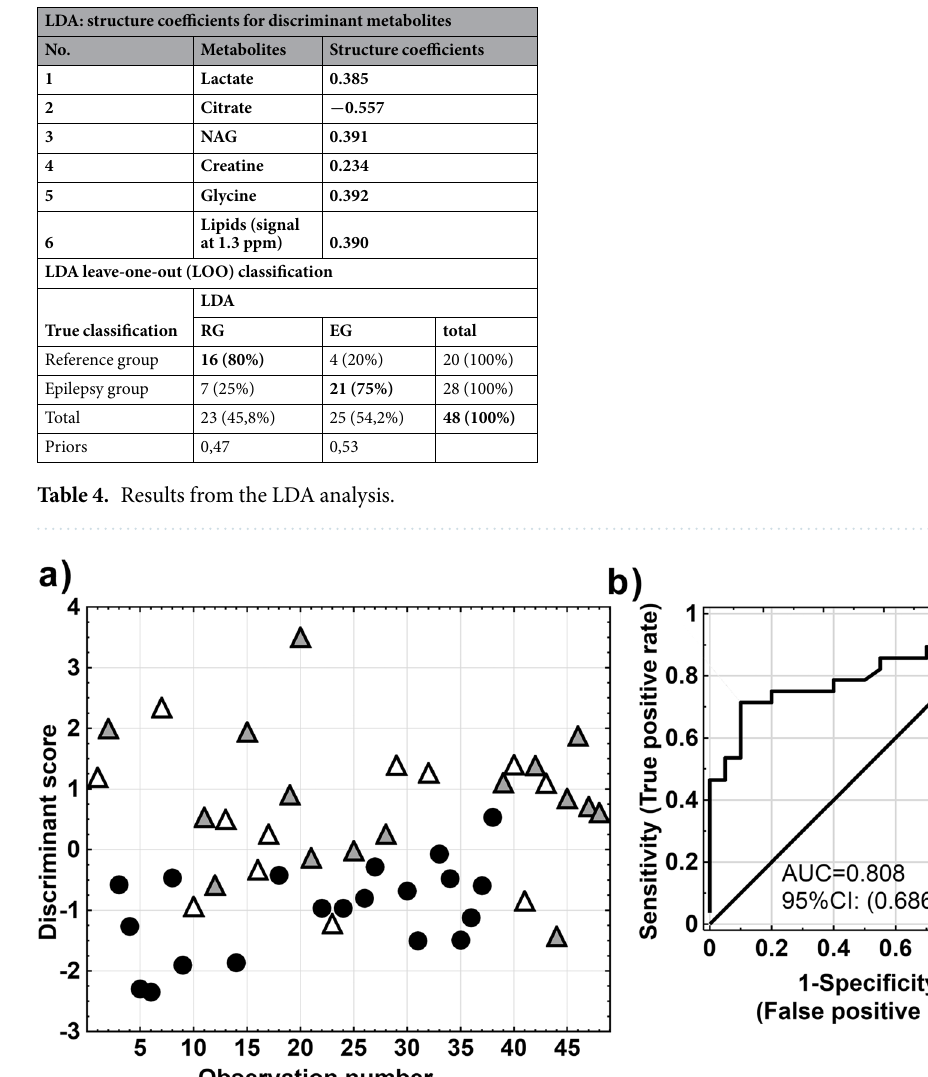
Figure 5. ( a ) Scatter plot of the LOO scores belonging to non-epileptic (RG, • ) and epileptic (EG 1 , Δ , EG 2 , ▼ ) children. ( b ) ROC plot for the leave-one-out (LOO) classification model; AUC equals 0.808 and 95%CI is (0.686, 0.931). The proposed threshold was 0.02, and the Youden’s index was